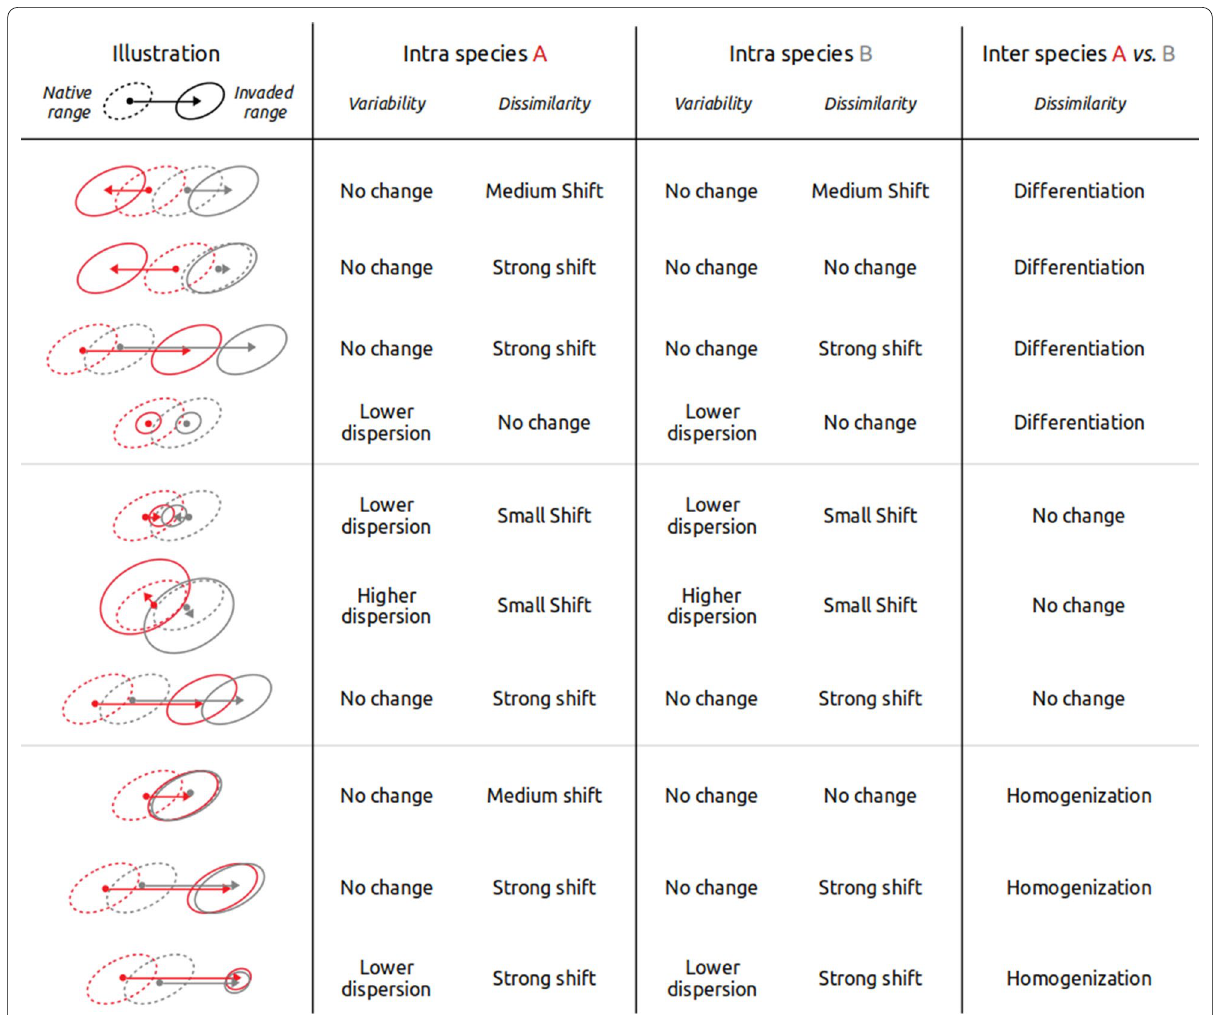
Fig. 1 Possible trajectories of microbiome modifications during invasion. This figure presents different possible trajectories of the microbiome of two invasive species (A in red and B in grey) in their native (dashed ellipses) and non‑native (continuous ellipses) ranges. Each ellipse represents the dissimilarity in microbiome composition between individuals from a given species and population, as often represented in an ordination. The microbiome of each species can become more or less variable in the non‑native range, as depicted by the size of the ellipses, while the non‑native microbiome can be more or less dissimilar to the native one, as depicted by the arrows and the degree of overlap between native and non‑native ellipses. Ultimately, these intra‑specific microbiome modifications could result in differentiation or homogenization of the microbiome between the species. These examples highlight the possibility of a similar inter‑species outcome arising from different combinations of intra‑specific trajectories. This framework can be applied to study inter‑specific modifications of other ecological traits than the microbiome (i.e. diet breadth, isotopic niche, morphological or behavioral traits) and in other contexts than invasions (e.g. response to